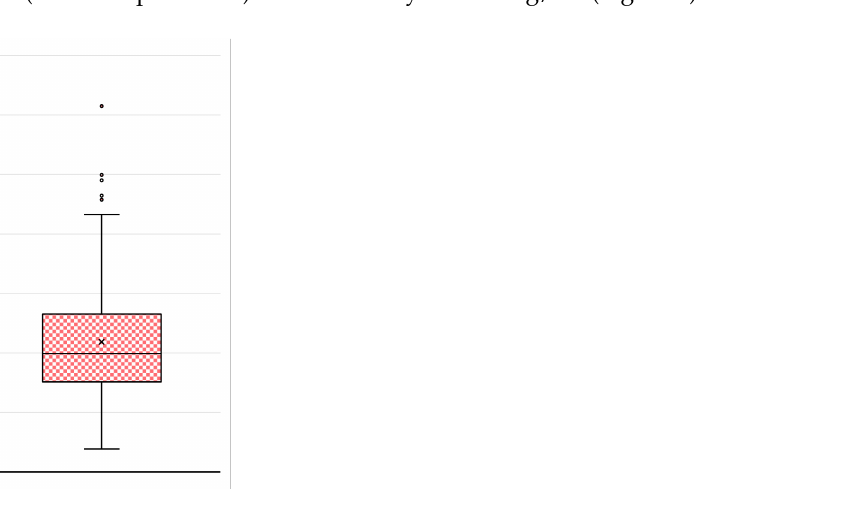
Figure 4. Free Hb levels in 116 leftover serum samples in clinical laboratory. Oxyhemoglobin was measured using 414 nm optical